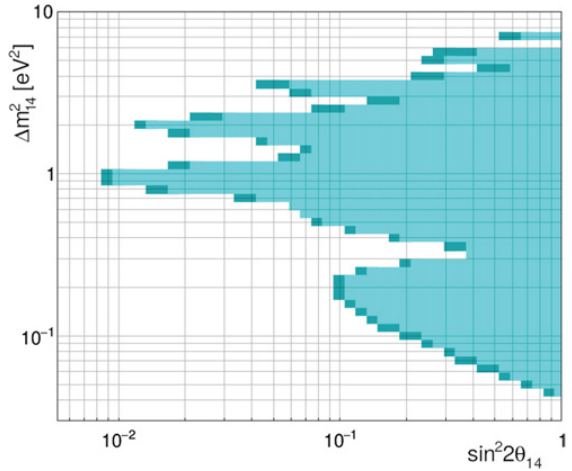
Figure 12. 90% CL exclusion areas in (cid:2) m 2 parameter space without systematic uncertainties (dark cyan) and with systematic uncertainties (light